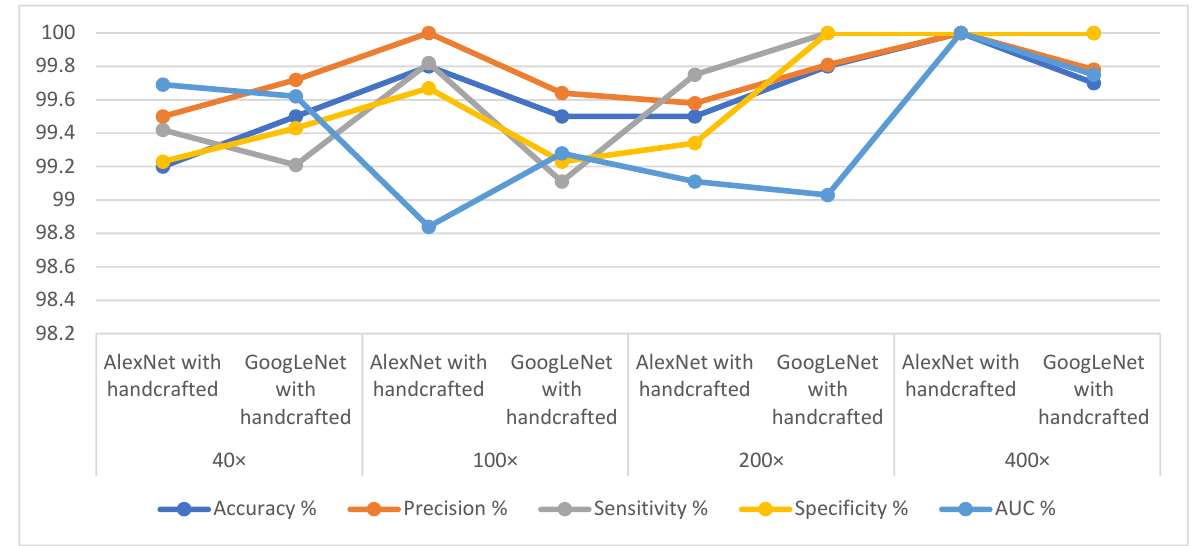
Figure 10. The execution of the ANN algorithm based on the fusion features. Figure 11 shows the confusion matrix of the ANN for diagnosing histopathological images of the BC dataset at a 40× magnification factor. The ANN algorithm was fed with fusion features, which produced the confusion matrix as Figure 11a, which reached an overall accuracy of 99.2% and an accuracy of diagnosing benign tumors of 97.6%; in con- trast, it reached an accuracy of 100% for diagnosing malignant tumors. The ANN was fed with fusion features, which produced the confusion matrix as shown in Figure 11b, which AUC of